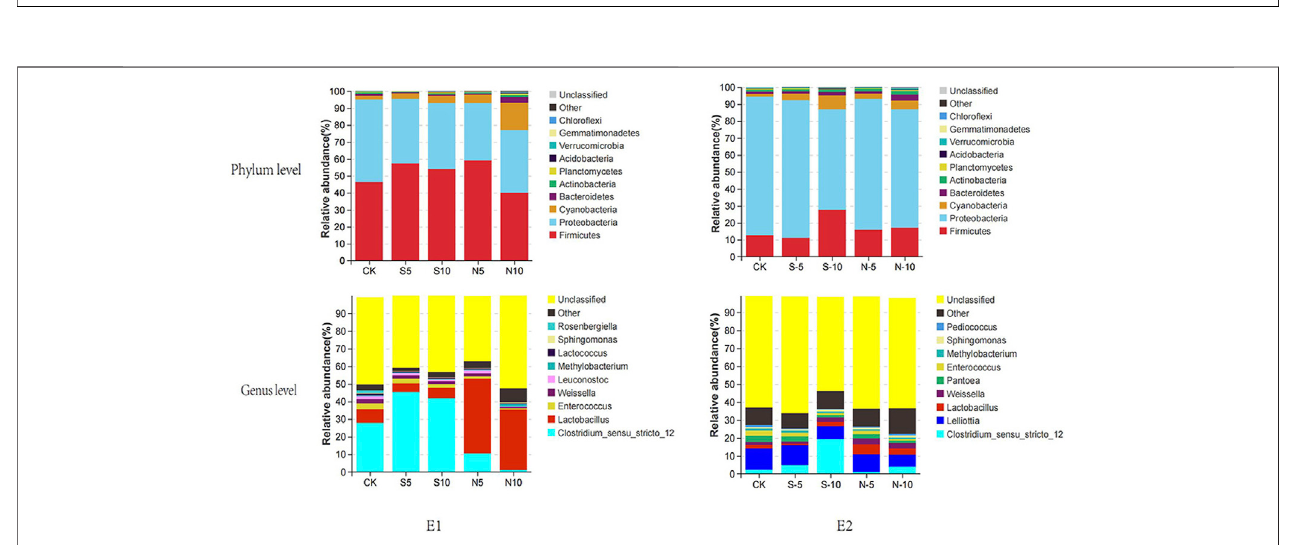
FIGURE 2 | Relative abundance of bacterial communities at phylum and genus levels of stylo silage mixed with stylo meal and N. cadamba leaf meal (E1 and E2, experiments 1 and 2; CK, control; S5 and S10, mixed with 5% and 10% stylo meal; N5 and N10, mixed with 5% and 10% N. cadamba leaf meal).